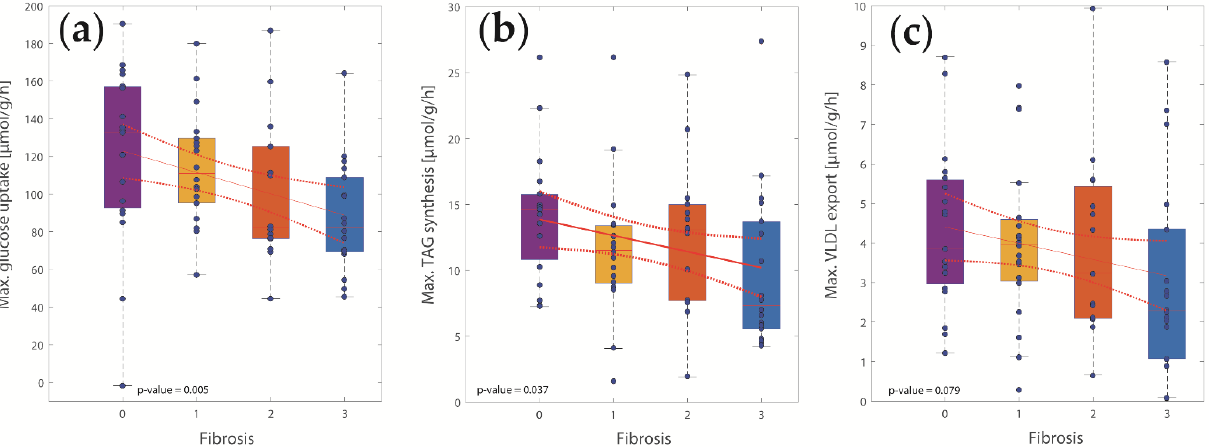
Figure 3. Relationship between histologically assessed liver fibrosis and various hepatic capacities. ( a ) Glycolysis; ( b ) TAG synthesis; ( c ) Lipoprotein production. A high degree of fibrosis is associated